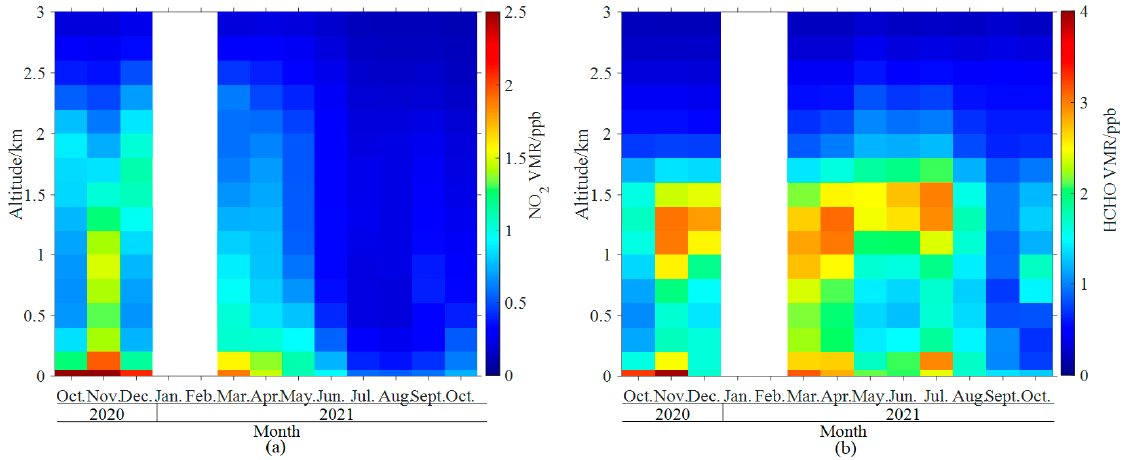
Figure 4. Monthly vertical profiles of ( a ) NO 2 and ( b ) HCHO VMRs.